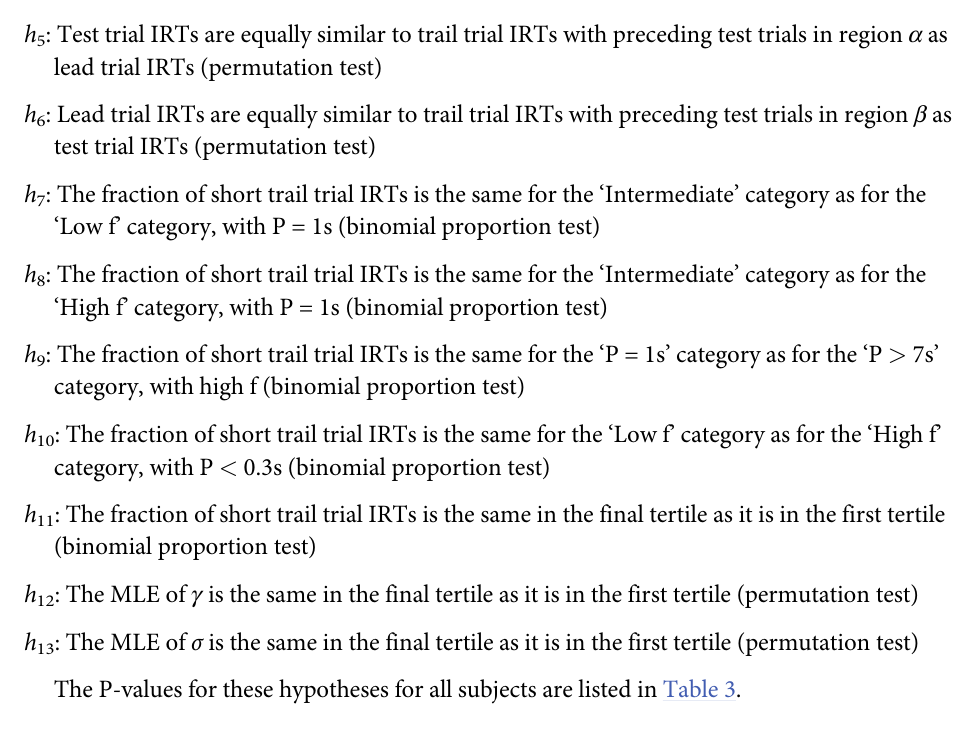
lead trial IRTs (permutation test)